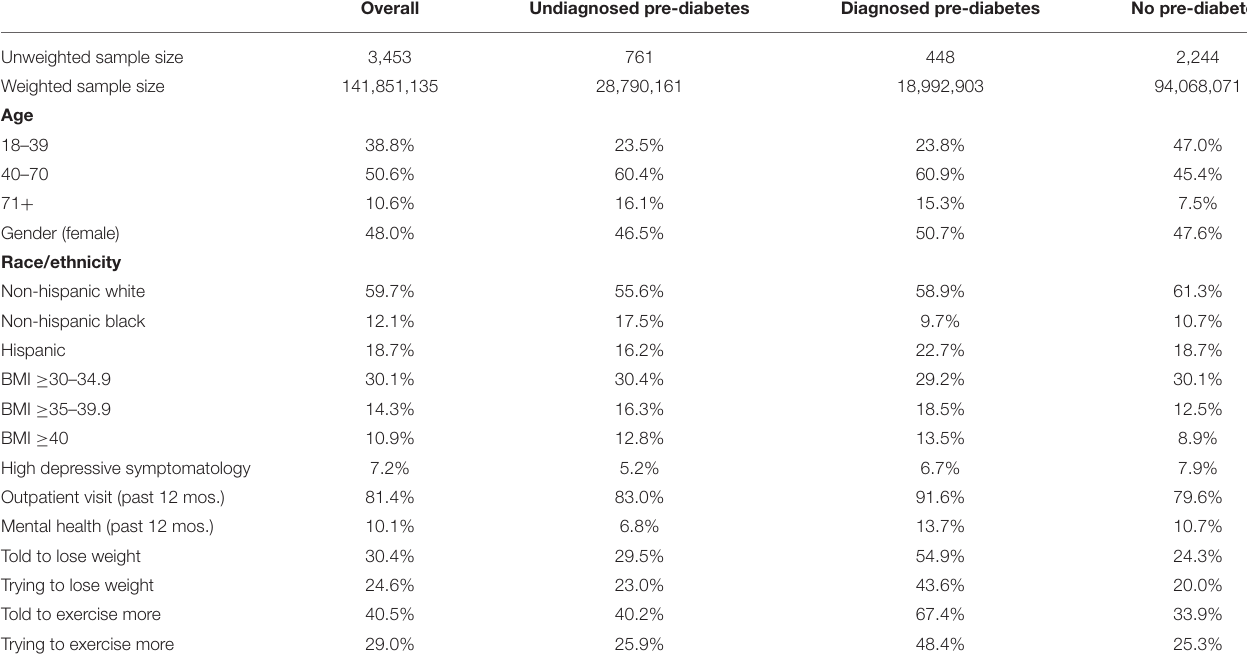
TABLE 1 | Descriptive statistics of overweight or obese adults who have never been diagnosed with diabetes. Overall Undiagnosed pre-diabetes Diagnosed pre-diabetes No pre-diabetes